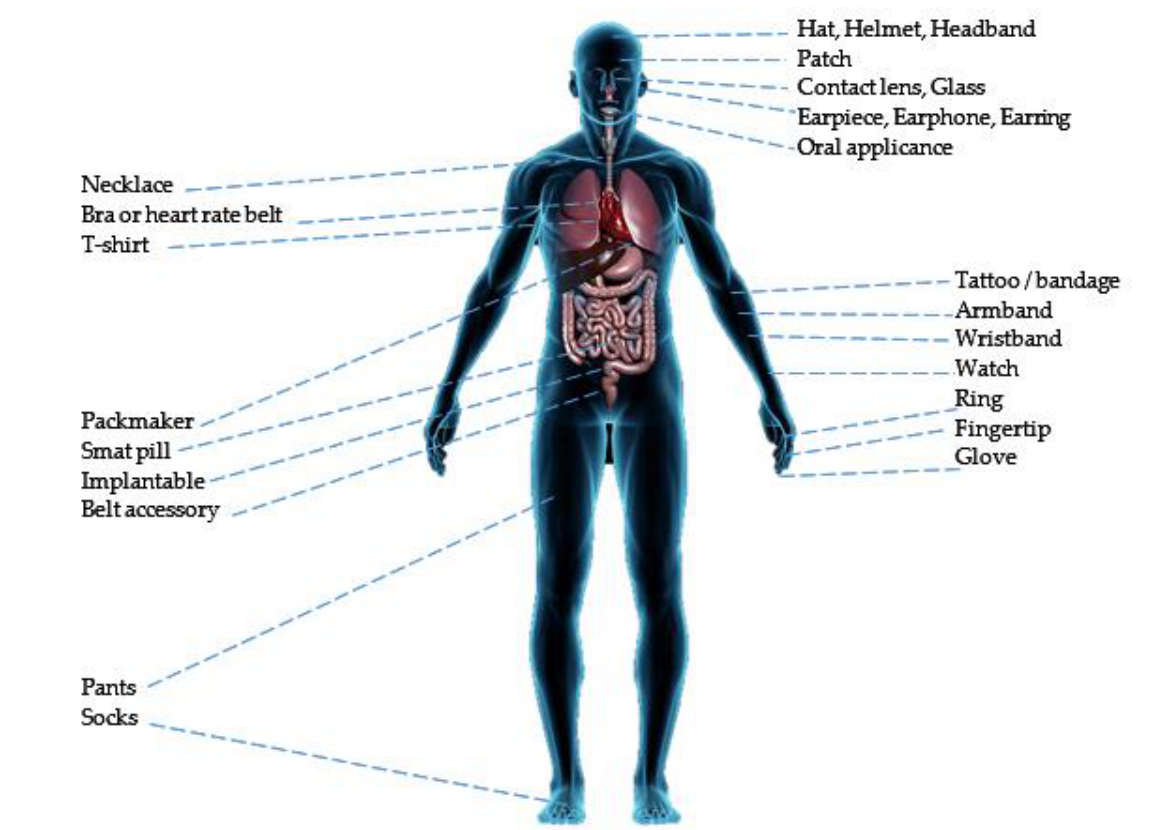
Figure 6. An overview of the different applications of wearable flexible sensors worn on various body parts.